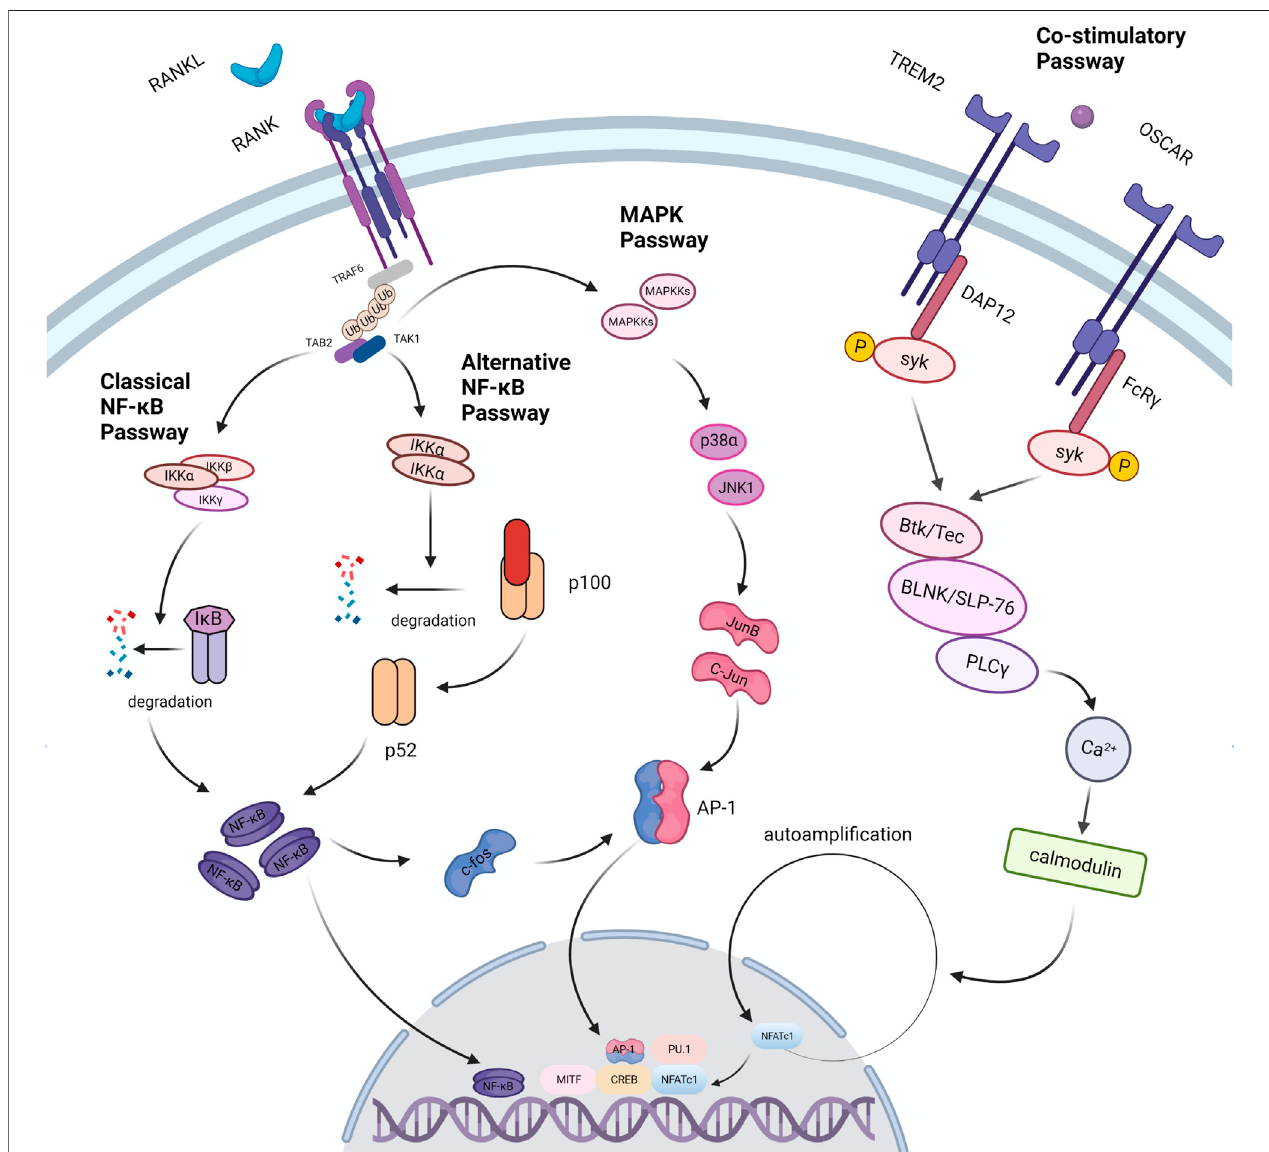
FIGURE 3 | Signal passways in the process ofosteoclastogenesis under the stimulation of RANKL. After RANKL binds to its receptor RANK, ittransduces signals through thelinker TRAF6, which recruits TAB2and TAB1toactivate the MAPK pathway and the NF- κ B pathway. NF- κ B isoneofthenecessarytranscription factors